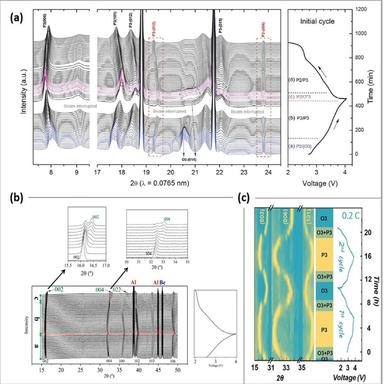
In-situ XRD patterns of different electrodes: (a) P2/P3-biphase Na0.7Li0.3Ni0.5Mn0.5O2 cathode during the initial cycles in Li-ion batteries (Reproduced with permission from ref. Copyright 2014 Wiley–VCH); (b) P2-phase Na0.67Mn0.8Fe0.1Ti0.1O2 electrode material at the rate of C/50 (Reproduced with permission from ref. Copyright 2016 American Chemical Society); (c) O3-type Na0.88Cr0.88Ru0.12O2 cathode for sodium-ion batteries during the initial cycles (Reproduced with permission f